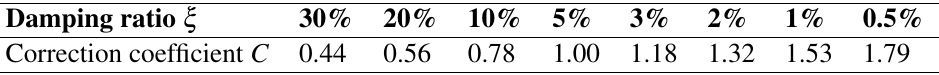
Table 4 Damping ratio correction coefficient C of the design response spectrum.